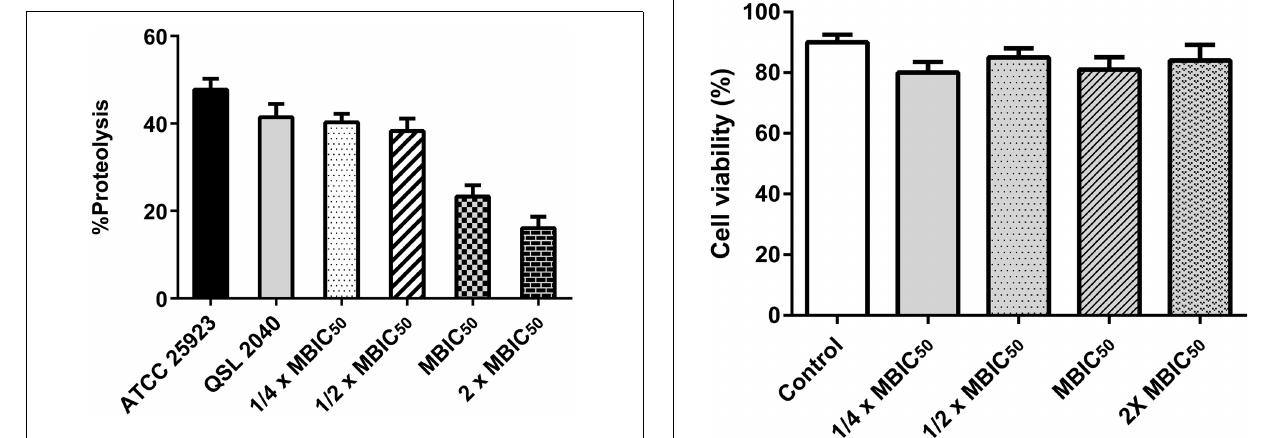
FIGURE 5 | Effect of ADM 3 on HEp-2 cell lines for cell viability by MTT assay. The concentrations used were 1 / 4 × MBIC 50 (1.25 µ g/mL), 1 / 2 × MBIC 50 (2.5 µ g/mL), MBIC 50 (5 µ g/mL), and 2 × MBIC 50 (10 µ